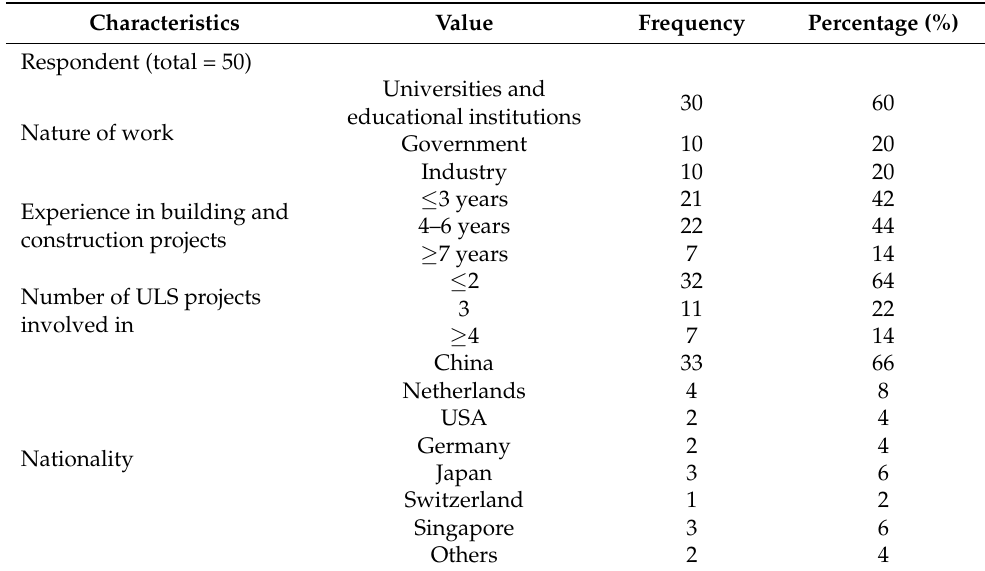
Table 2. Profile of survey